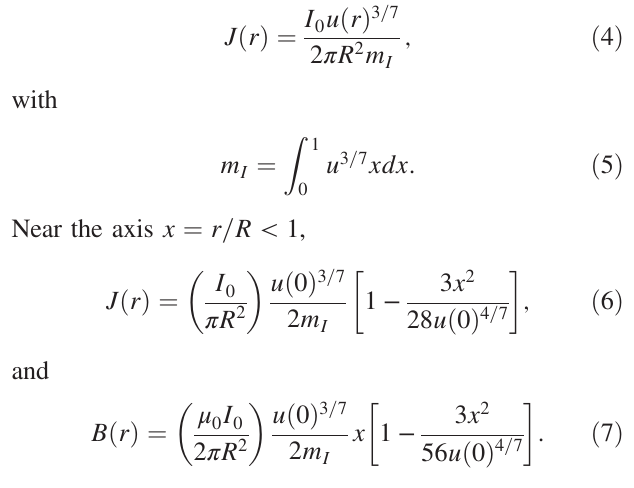
FIG. 1. MHD simulations of a 1-mm-diameter plasma lens yield the radial distribution of (a) the electron temperature and plasma density, (b) the transverse current density, and (c) the magnetic field profile. A simplified model was proposed (plotted as solid blue curves), based on J ð r Þ ∝ T e ð r Þ 3 = 2 , with T e ð r Þ ∝ u ð r Þ 2 = 7 as described in Ref. [34]. One can observe an approx- imately 35% enhancement in near-axis current density and B-field